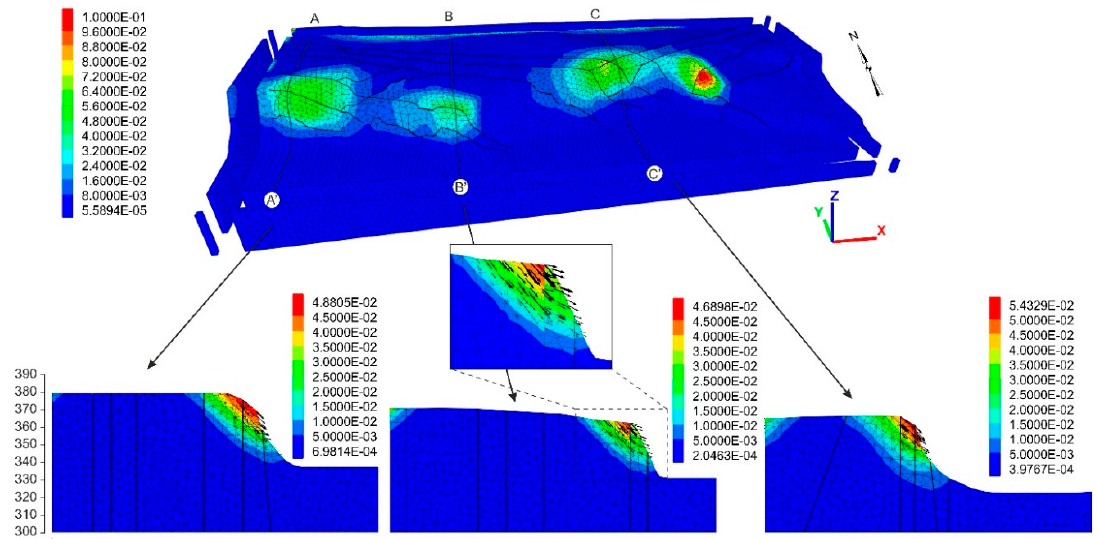
Figure 20. Contour displacements and displacement vectors (sections) of the dynamic analysis with Mw 5.5 input on the pre-landslide model with discontinuities.